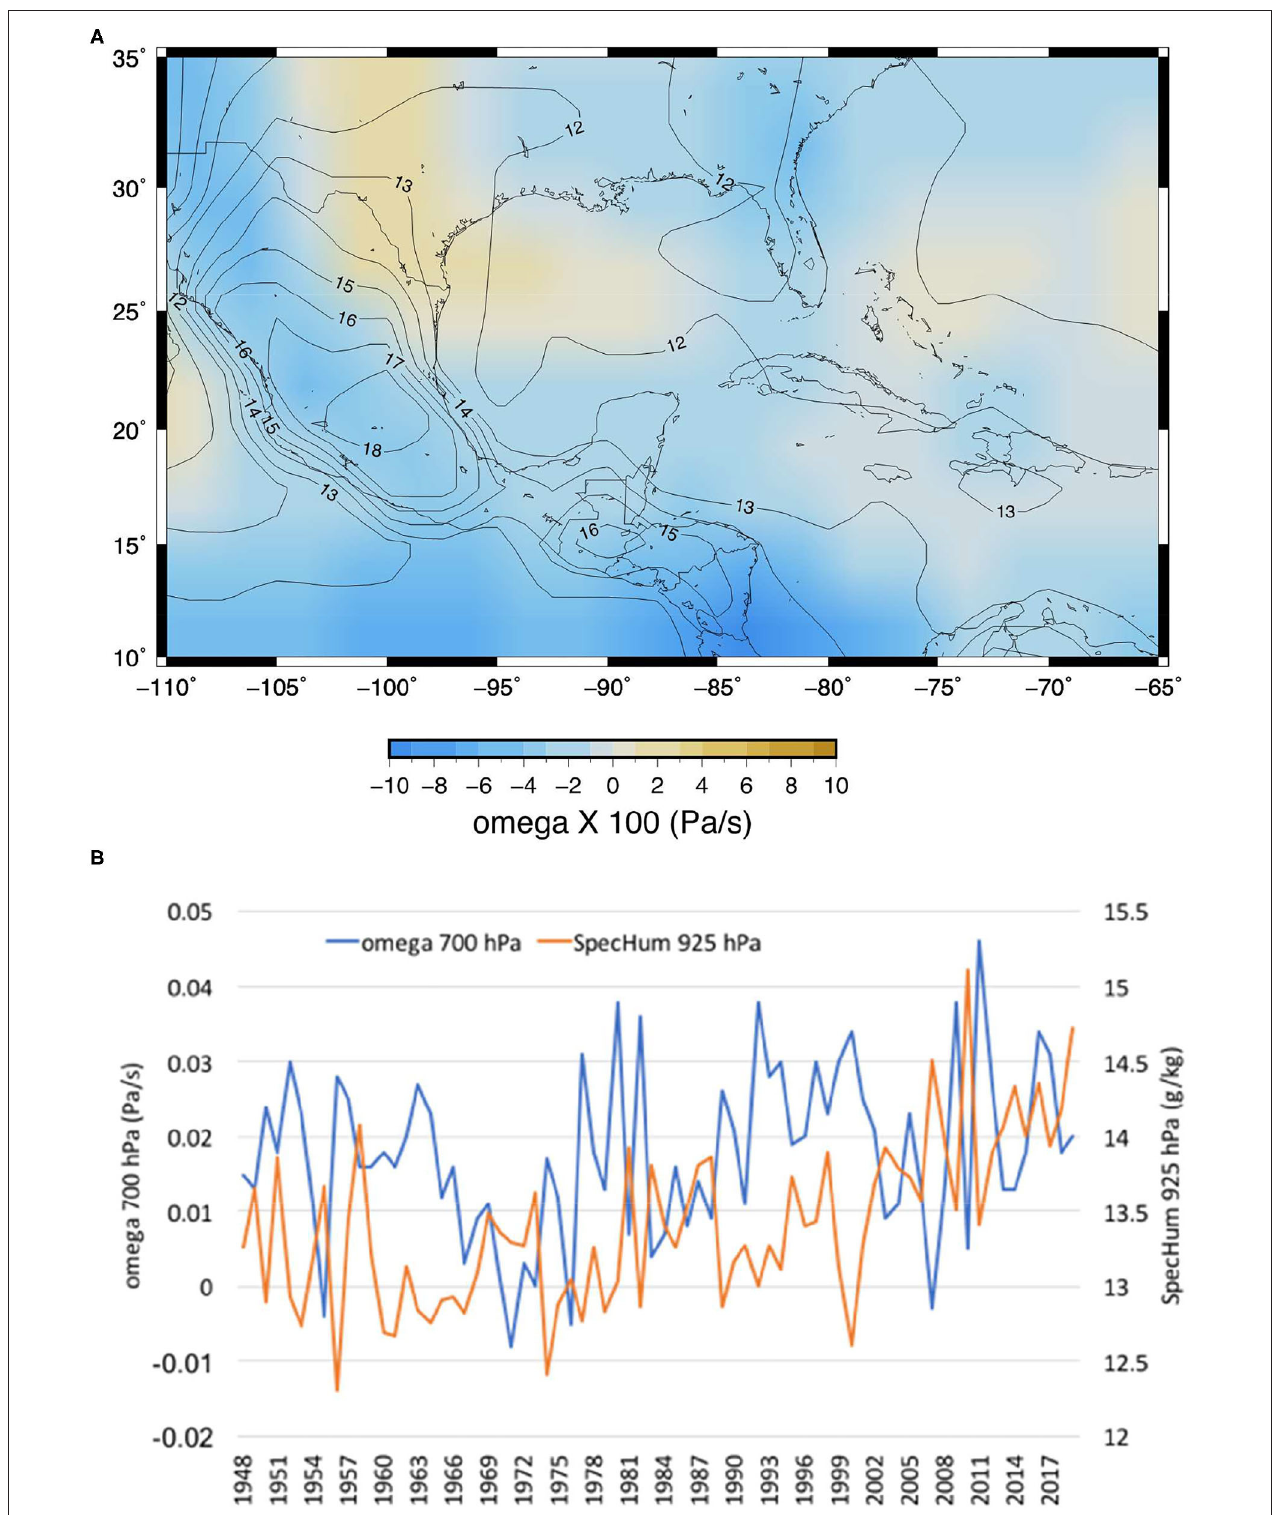
FIGURE 5 | (A) Climatology of omega vertical velocity (Pa/s) at 700 hPa over the IAS, Mexico and Central America between June and September. Tan (blue) color indicates regions of atmospheric subsidence (ascending) motions. Isolines correspond to specific humidity (g/kg) at 925 hPa for the same months. (B) Time series (1948–2019) of vertical ascending motions (Pa/s) at 700 hPa (blue line) and specific humidity (g/kg) at 925 hPa (orange line) over NE Mexico (at 100 ◦ W, 25 ◦ N).